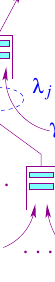
Figure 1. Node model for Jackson